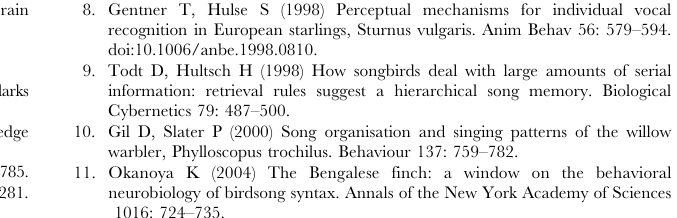
Fig. 7 , all other colors are arbitrarily assigned. A square flanks each barcode to indicate the scale, with the width corresponding to 2 seconds and the height to 20 trials. Figure S7 Using cross-validation to verify PST fits. To select the parameters used in the PST algorithm, we used a 10-fold cross-validation procedure repeated 3 times (with different data splits). Figure S9 Shown are the transition probabilities from two different phrases sung by the same bird as a function of repetition number. Left: as phrase X is repeated, the most probable phrase transition from X to G decays, while the transition to S increases. Right: the opposite effect is seen in the same bird. The most probable transition, from H to X, increases as H is repeated. Figure S10 Some syllables have context-dependent transitional forms. A, shown on the left are two example sonograms of the same phrase with different preceding phrases. In the two contexts, the first syllable of the phrase has a different transitional form (highlighted by the red and blue boxes). The image on the right is a color channel merge of two spectral density images, which were computing using the first syllable of all phrases in the two different contexts (top sonogram context is the red channel and bottom sonogram context the blue channel). B, the same effect is shown for a different phrase from a different bird. Figure S11 Probabilistic finite automata (PFA) for all 6 birds analyzed. For visualization, all edges where p , .05 have been removed, and all edges where p , .2 are shown in thin light gray lines. Each PFA is completely determined by its correspond- ing PST. From top to bottom, the PFAs correspond to the PST shown in: the top left of Fig. S8 ; top right of Fig. S8 ; top of Fig. 5 ; bottom left of Fig. S8 ; bottom of Fig. 5 ; bottom right of Fig. S8 .